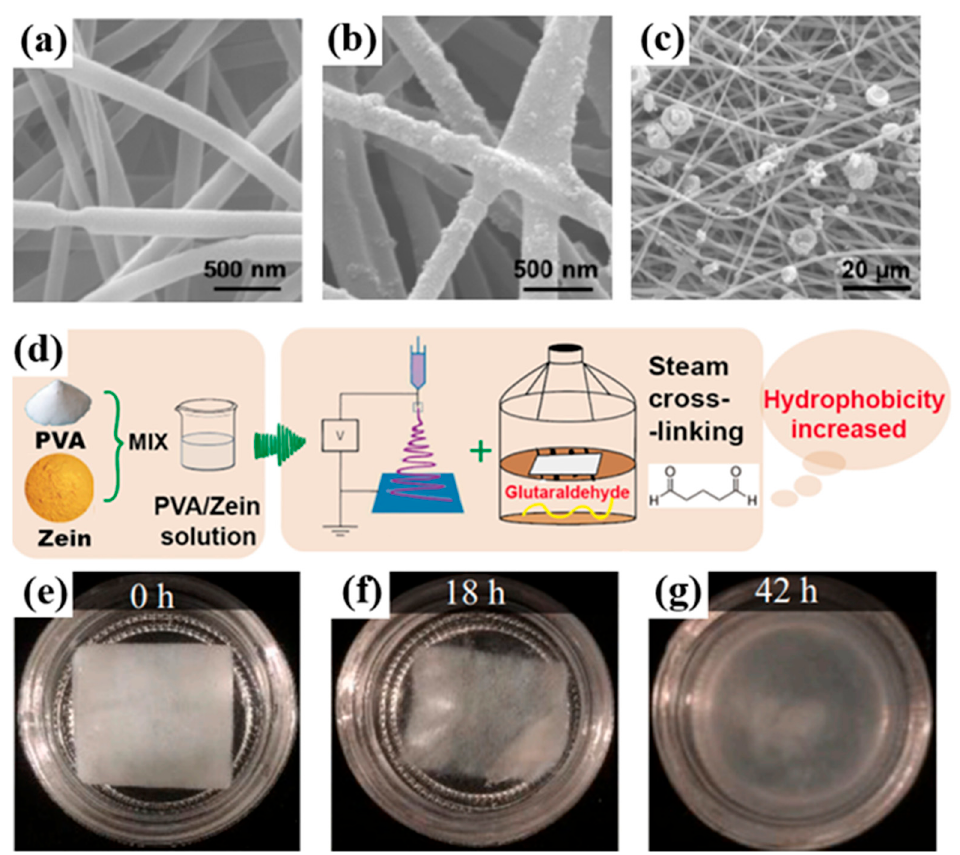
Figure 8. ( a ) SEM image of zein nanofiber membrane before filtration. ( b , c ) SEM images of zein nanofiber membrane after filtration [118]. ( d ) Schematic preparation and design of the filter based on hydrophobic cross-linked zein nanofibers [119]. ( e – g ) Images of enzymatic degradation testing [120].